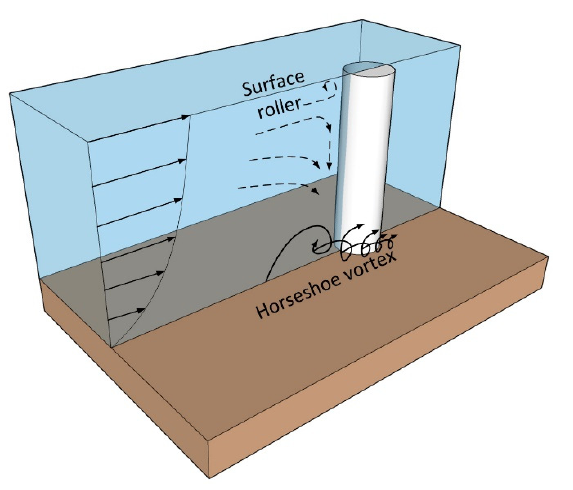
Figure 3. Mechanics of scour [27].